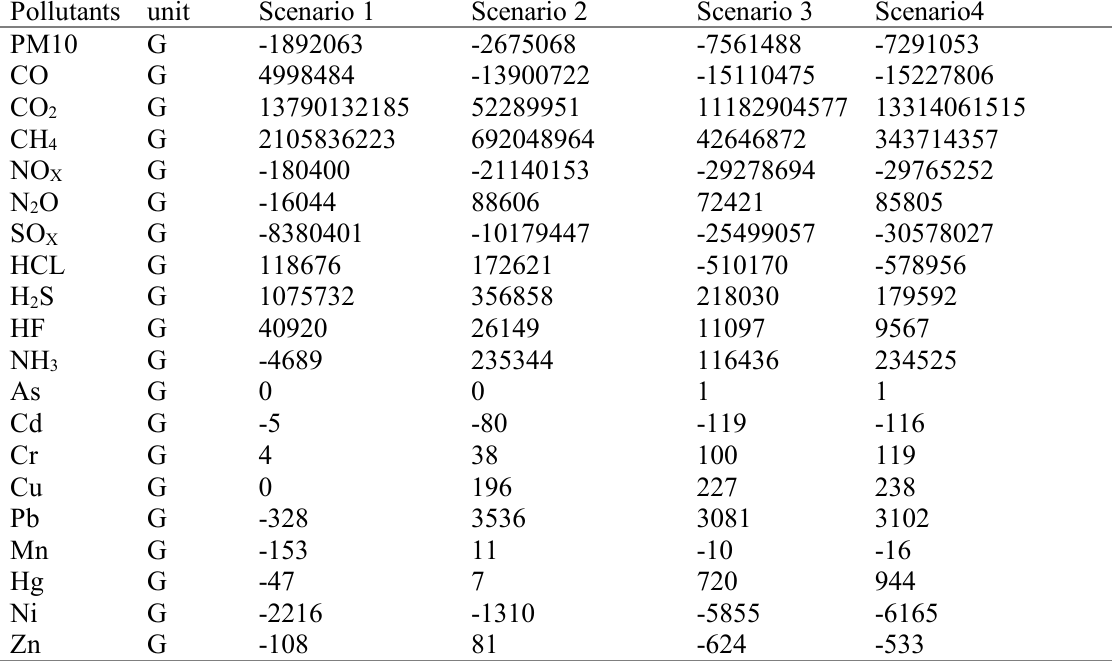
Table 4 . air Emissions in different scenarios per functional unit (annual waste